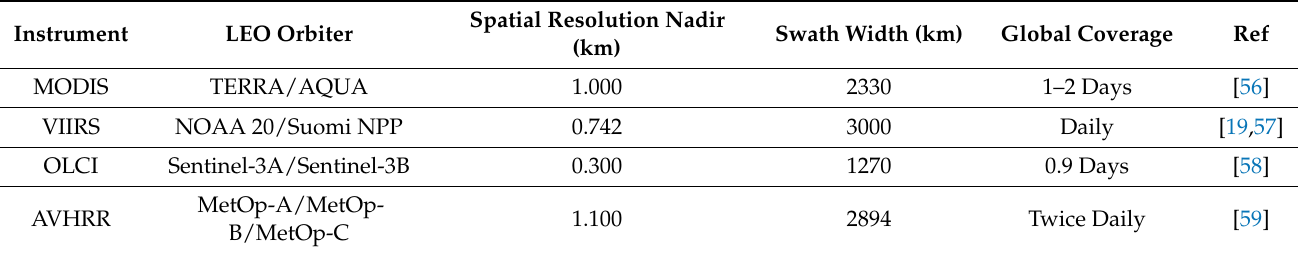
Table 5. LEO visible band instruments to provide integrated global coverage.